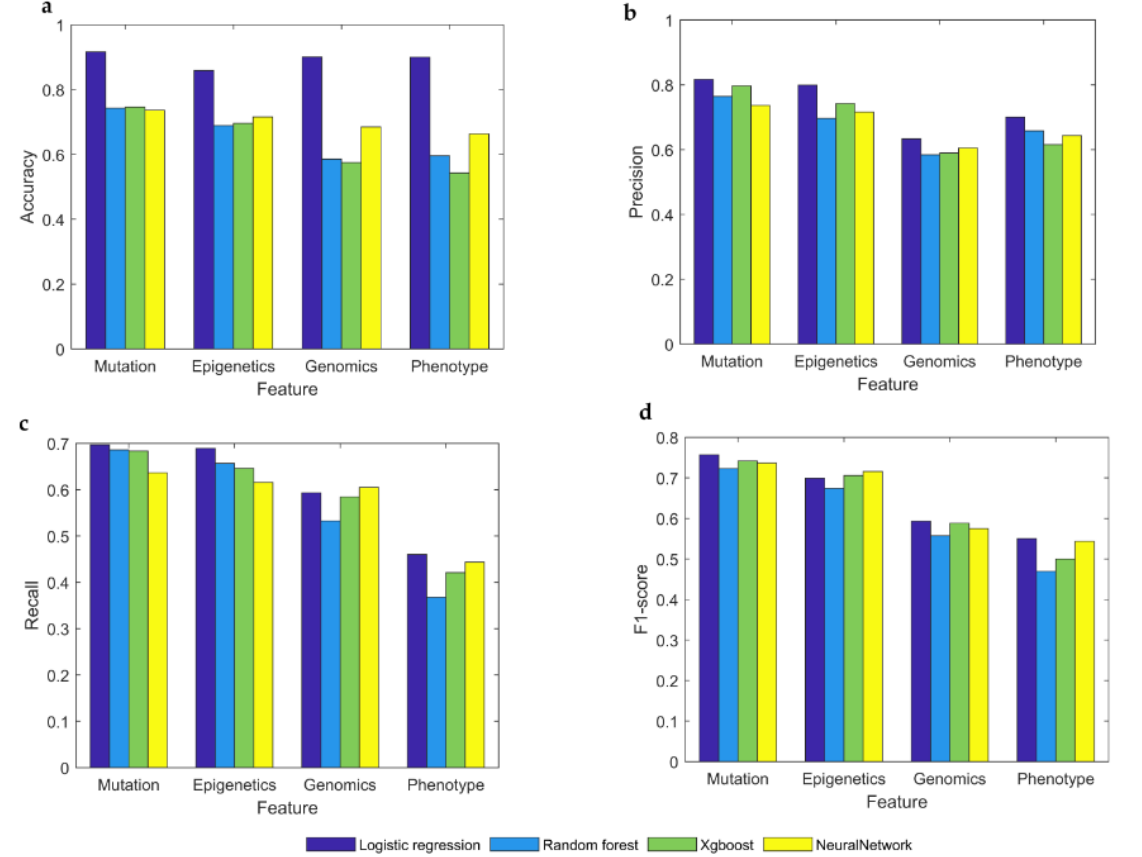
Figure 3. Detect driver genes from a single type of feature by four machine learning algorithms. ( a – d ) Compare four algorithms on accuracy, precision, recall, and F1-score. In each graph, the X-axis represents omics features. The Y-axis represents the value of accuracy, precision, recall, or F1-score, respectively.